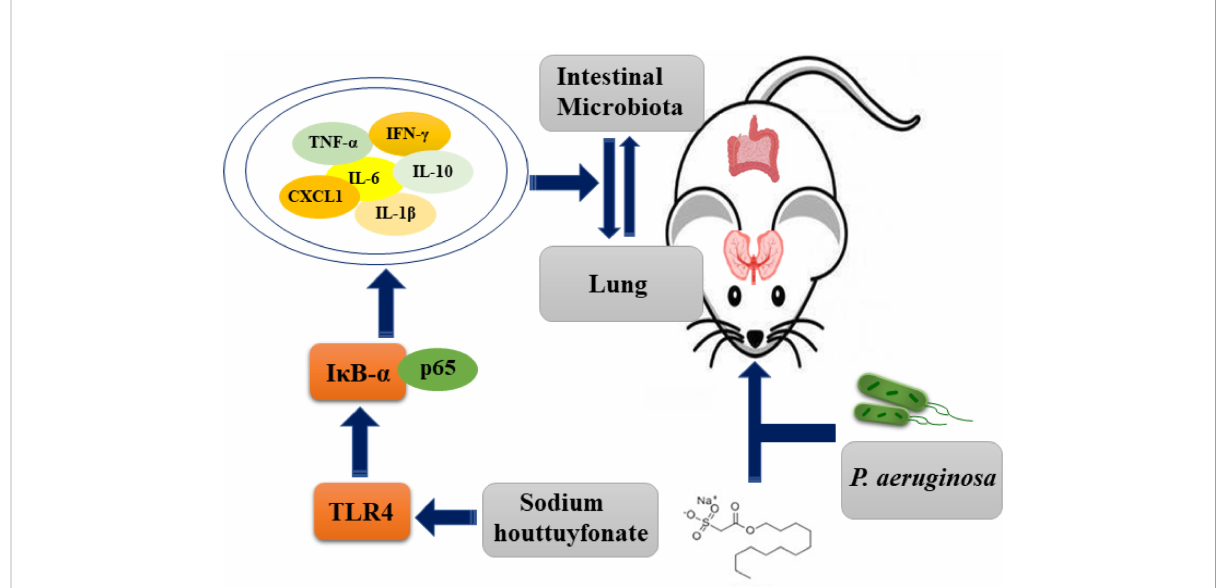
FIGURE 9 Schematic diagram of the possible mechanism of sodium hottuyfonate against acute pulmonary infection by P. aeruginosa . SH can regulate the immune and intestinal fl ora disorders of mice through TLR4/NF- k B signaling pathway, and effectively alleviate acute lung infection caused by P. aeruginosa